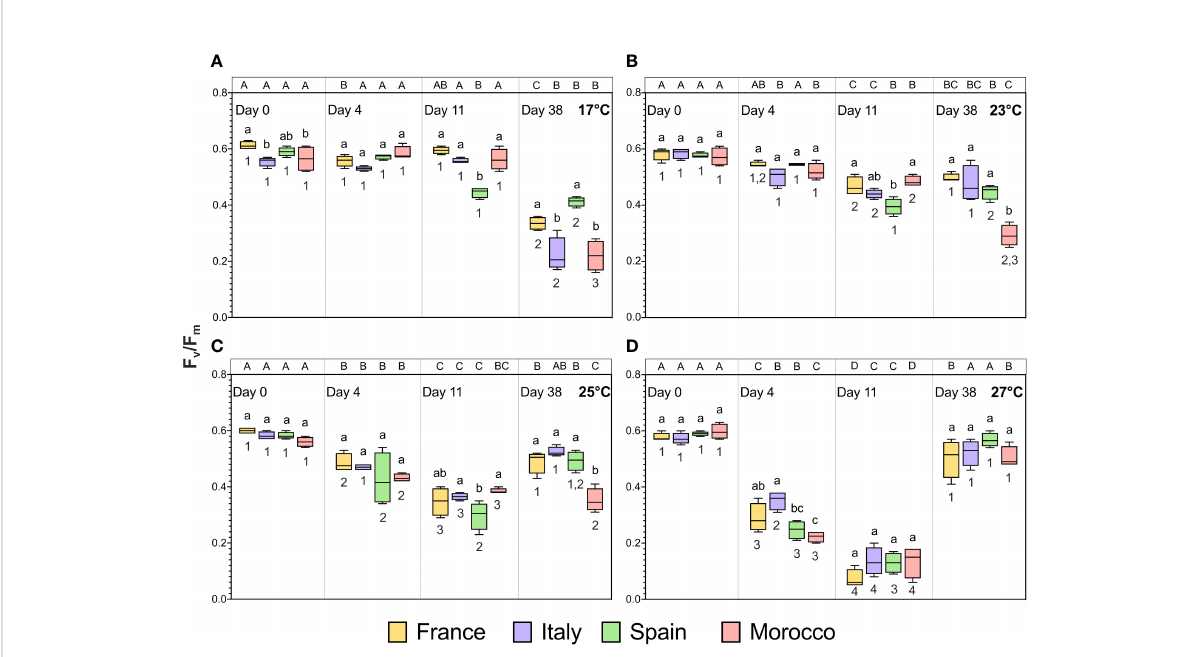
FIGURE 4 Maximum quantum yield of photosystem II (F v /F m ) of Laminaria ochroleuca gametophytes from different populations (FR, IT, SP, MO) exposed to thermal treatments of 17°C (A) , 23°C (B) , 25°C (C) and 27°C (D) over time (heat wave: days 0, 4, 11 and recovery: day 38). Box plots with median, boxes for 25 th and 75 th percentiles and whiskers indicating min and max values (n = 4). For each temperature and time period, different lowercase letters above boxplot bars indicate signi fi cant differences between populations. For each population and temperature, different uppercase letters indicate differences between time periods. For each population and time period, different numbers indicate differences between temperatures ( p < 0.05). See Table 3 for statistical